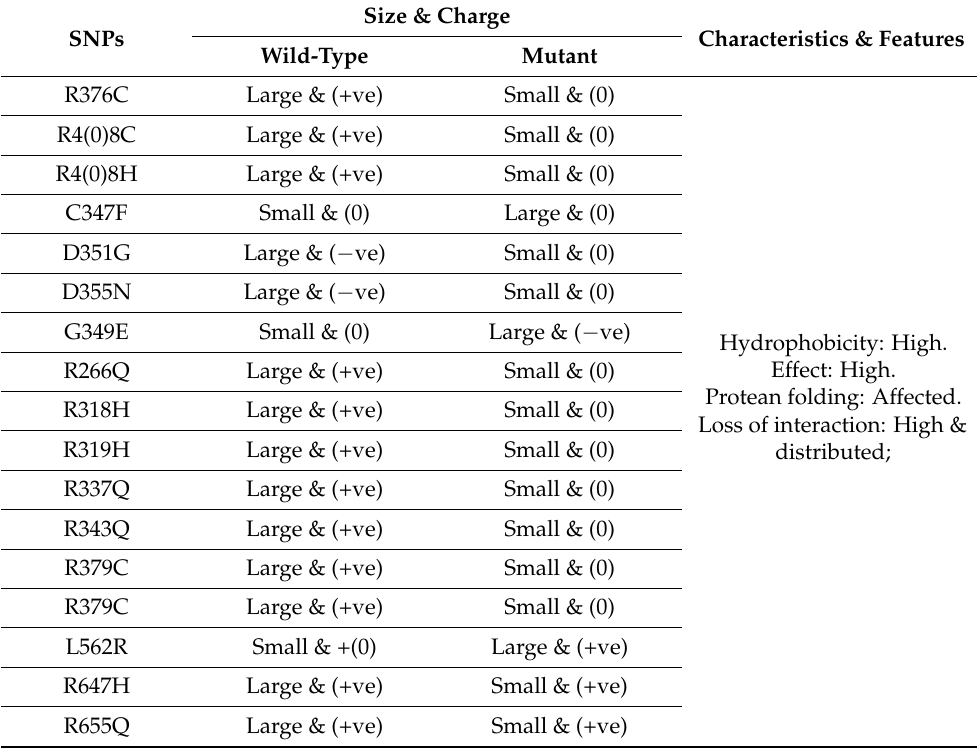
Hydrophobicity: High. Effect: High. Protean folding: Affected. Loss of interaction: High